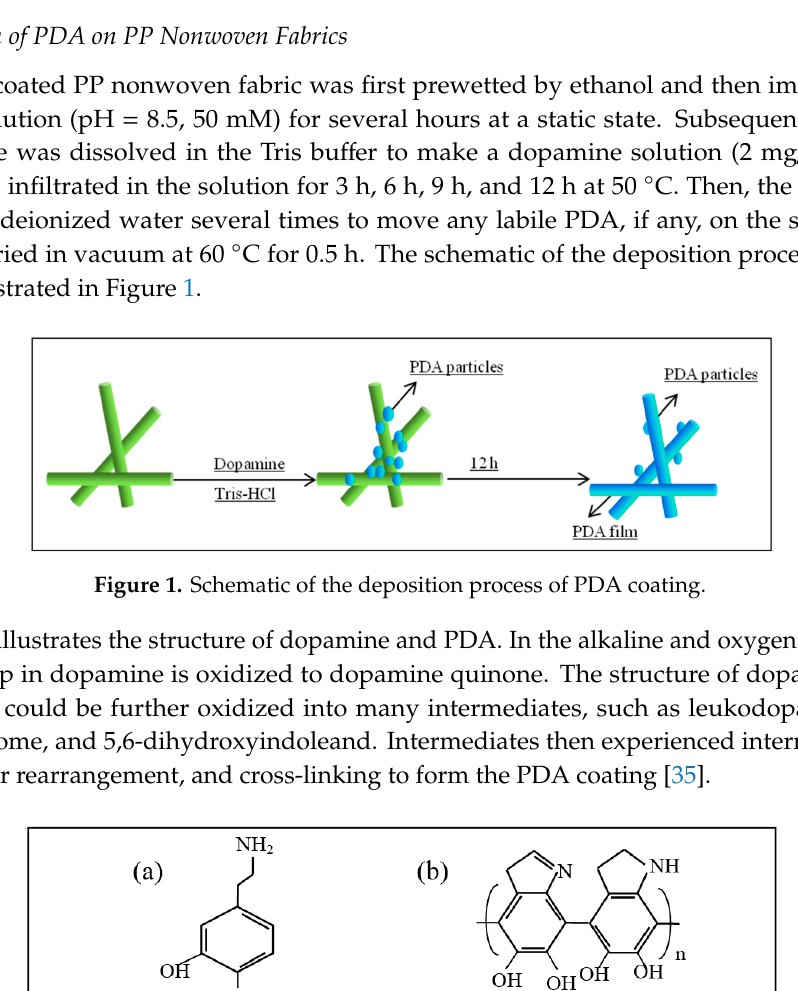
Table 1. Deposition parameters of Ag film.